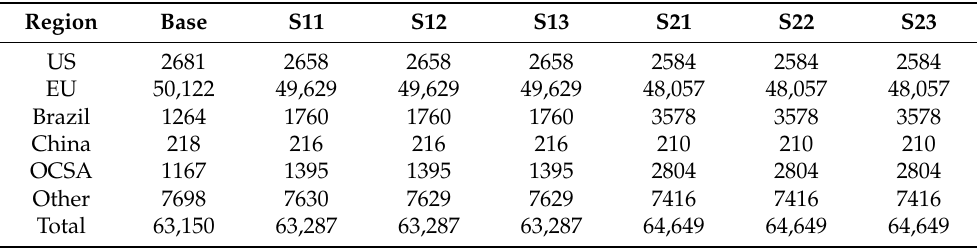
Table 5. EU imports of beverages and sugar from exporting regions for all examined scenarios (in million USD).